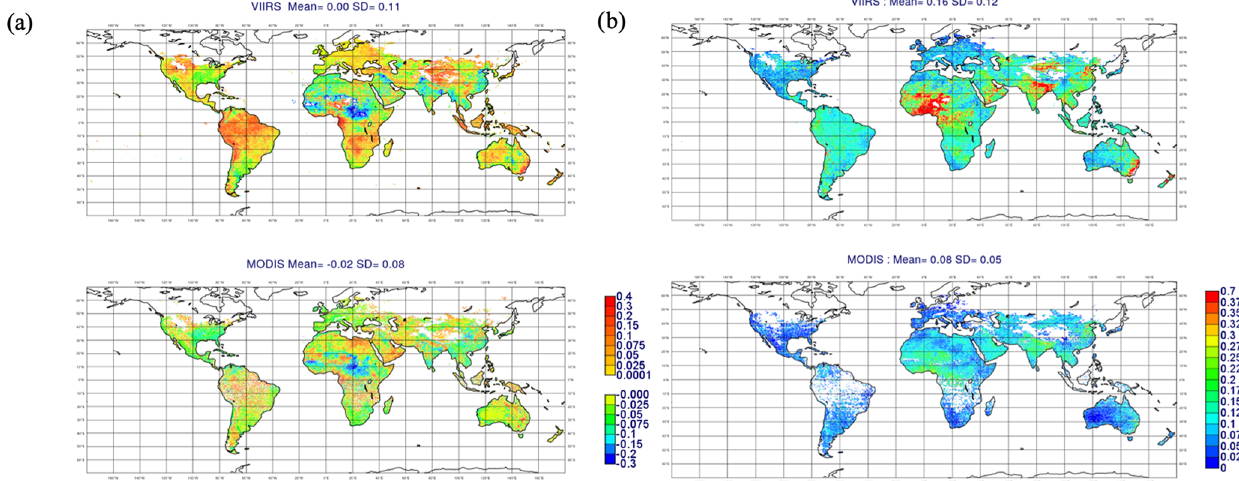
Figure 13. Global maps of the mean (a) and SD (b) of the first-guess departure from Terra and Aqua/MODIS as well as NOAA20 and SNPP/VIIRS for the DJF (2019–2020) period over land.